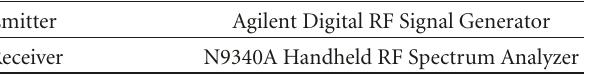
Table 2: Measurement equipment.